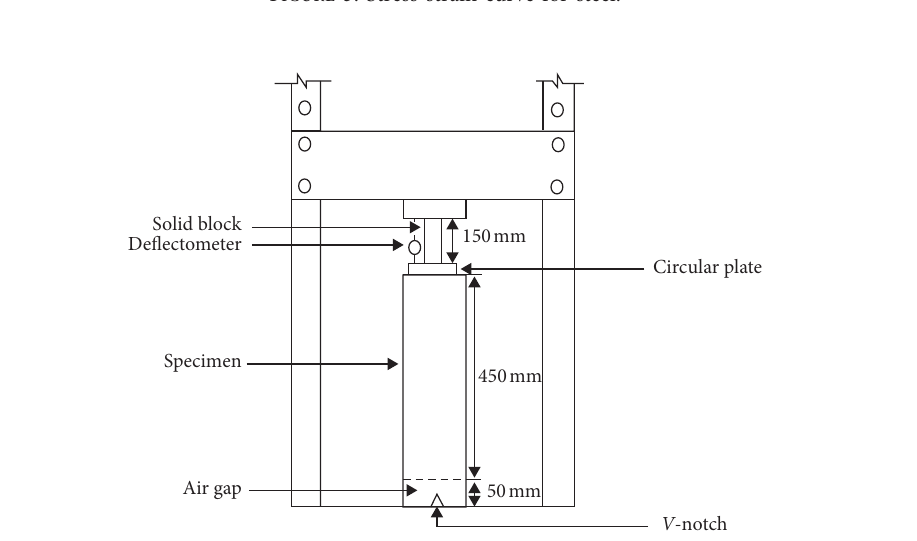
Figure 3: Stress-strain curve for steel.